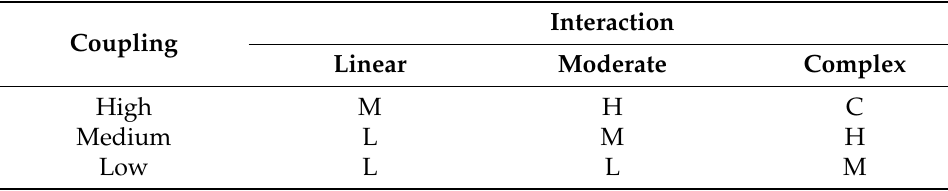
Table 3. Using coupling and interaction level to determine the severity of accident the system may experience. Adapted from Reference [9].